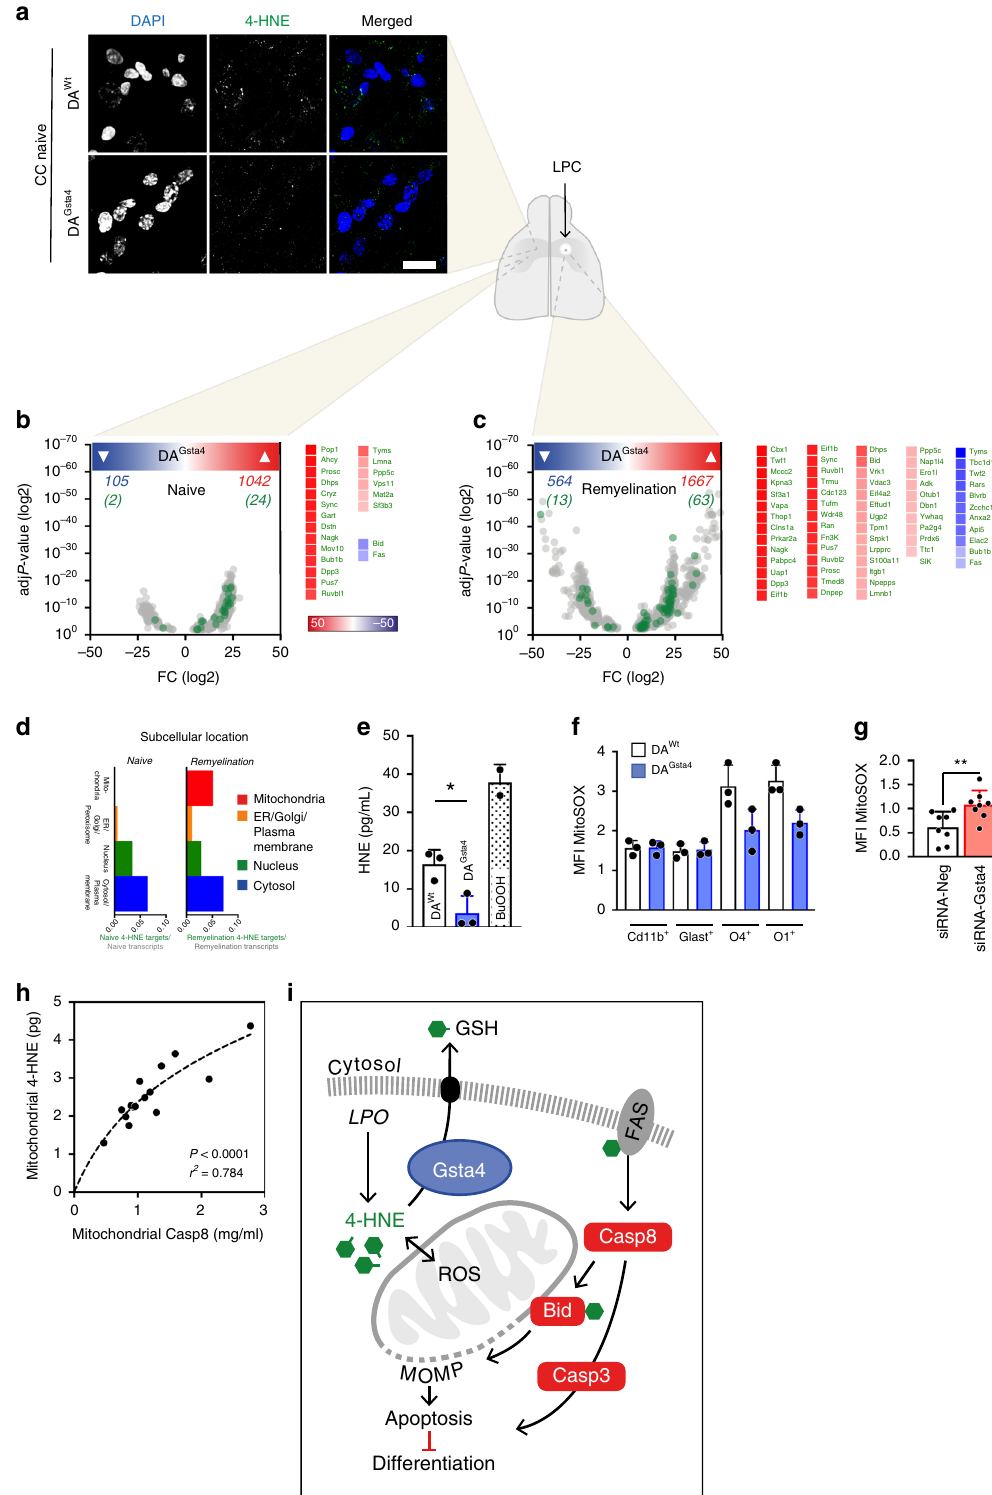
to glial cells but DA Gsta4 OLs had a reduced MitoSOX signal compared to DA Wt (Fig. 4f). This was then increased upon addition of siRNA-Gsta4 in vitro (Fig. 4g). Furthermore, mitochondrial 4-HNE load showed a positive correlation with activated Casp8, suggesting that the bene fi cial effects of Gsta4 on OL apoptosis involves mitochondrial 4-HNE load (Fig. 4h). Taken together our data indicate that Gsta4